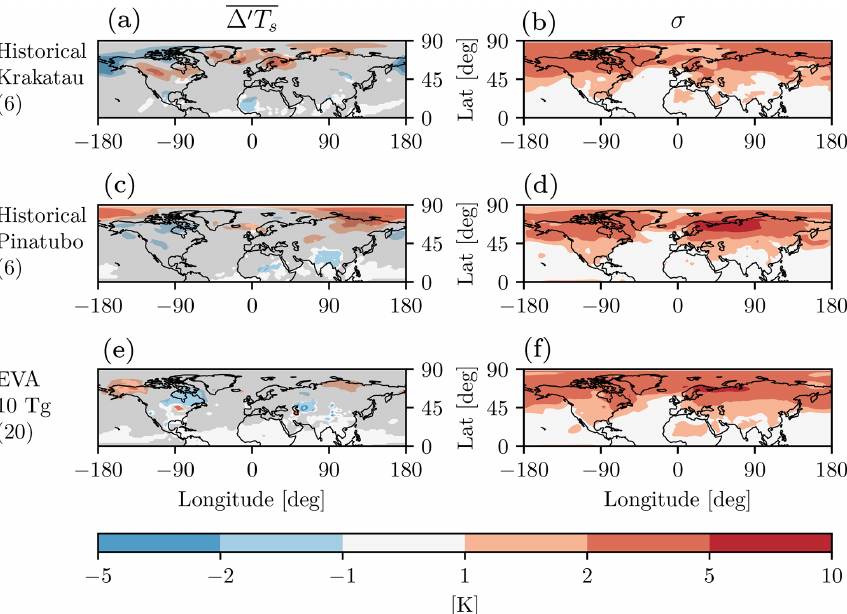
Figure A3. As in Fig. 5, but using the difference-from-reference-period method, for Krakatau (a, b) , Pinatubo (c, d) , and EVA aerosols at 10Tg(S) (e, f) , with the ensemble size in parentheses in (a) , (c) , and (e) .